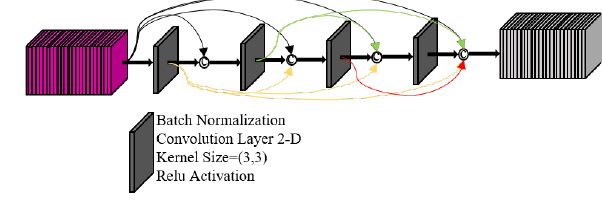
Figure 3 . The structure of Dense block. Figure 4 depicts the structure of a transition block. This block includes a convolution layer and a max-pooling layer for feature size map reduction.